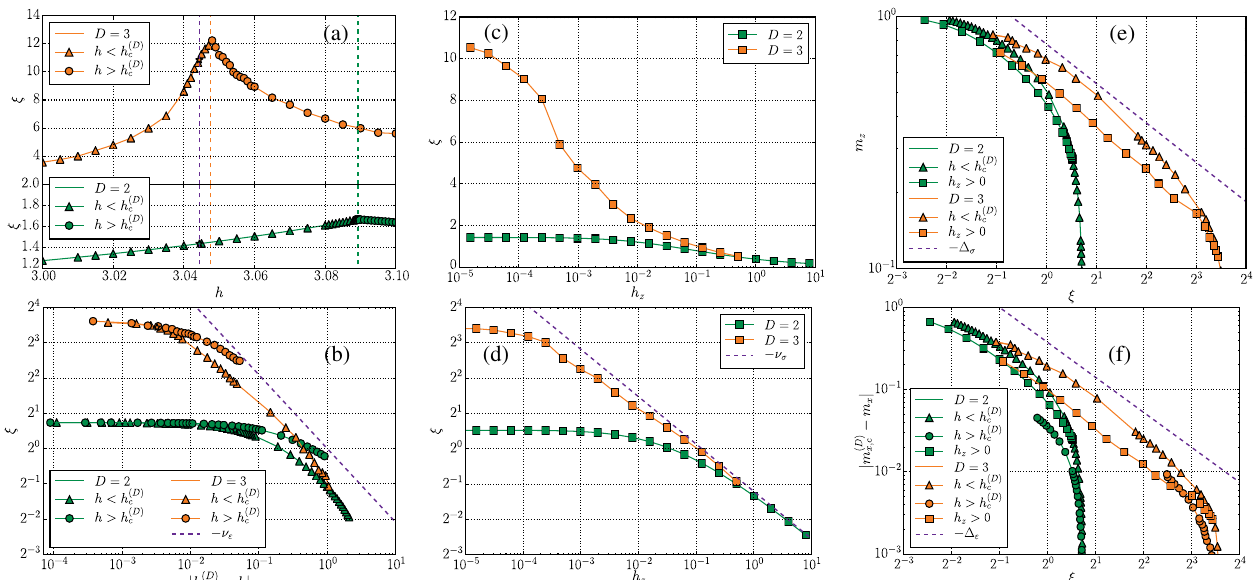
FIG. 4. Correlation lengths of the variationally optimized iPEPS states for D ¼ 2 and D ¼ 3 . (a) Correlation lengths as a function of ð D Þ − h j on a log-log scale, including the theoretically expected slope − ν the transverse field h . (b) Correlation lengths as function of j h c ϵ . (c) Correlation lengths as a function of the longitudinal field j h z j . (d) Correlation lengths as function of j h z j on a log-log scale, including ð D Þ the theoretically expected slope − ν σ . Panels (e) and (f) display the expectation value of m z and j m x;c − m x j , respectively, as a function of the correlation length ξ , on a logarithmic scale. The expected slopes in the two cases are directly the (negated) scaling dimensions − Δ σ and − Δ ϵ . The values of the exponents and scaling dimensions can be found in Table